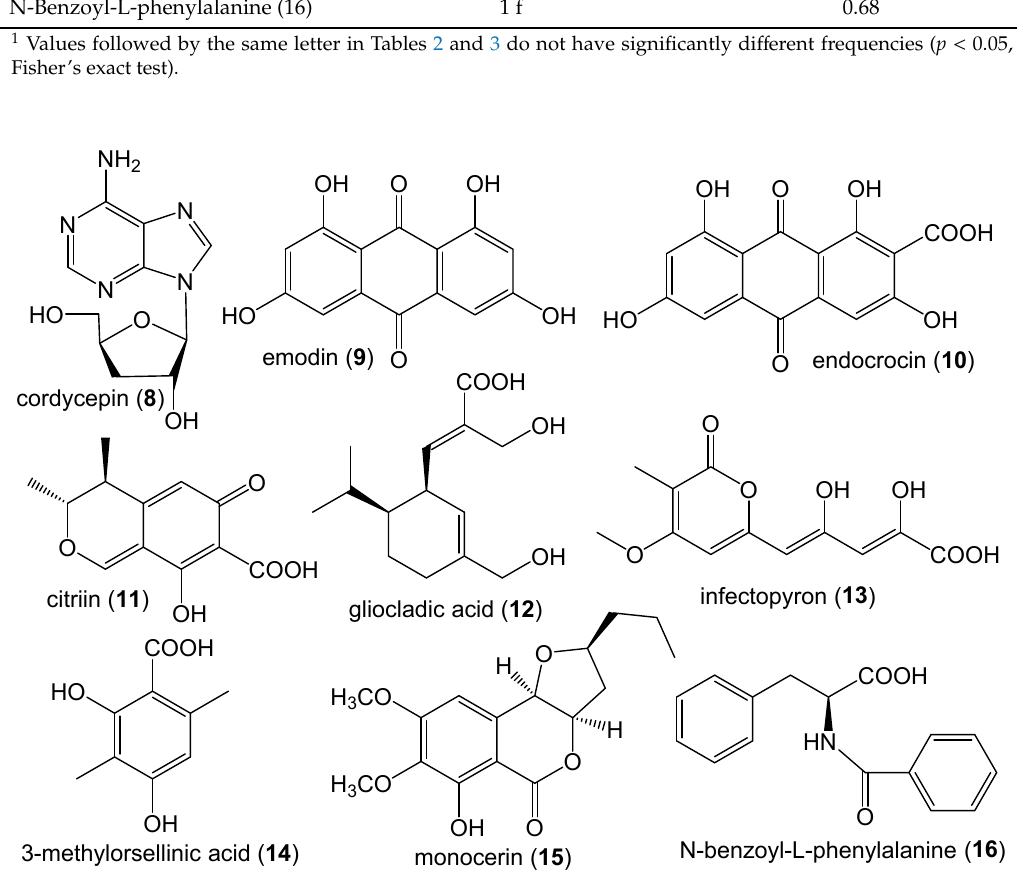
Figure 4. Structures of mycotoxins and secondary metabolites produced in the culture media by M. phaseolina in less than 5% of the 89 M. phaseolina isolates from soybean plants symptomatic for charcoal rot.